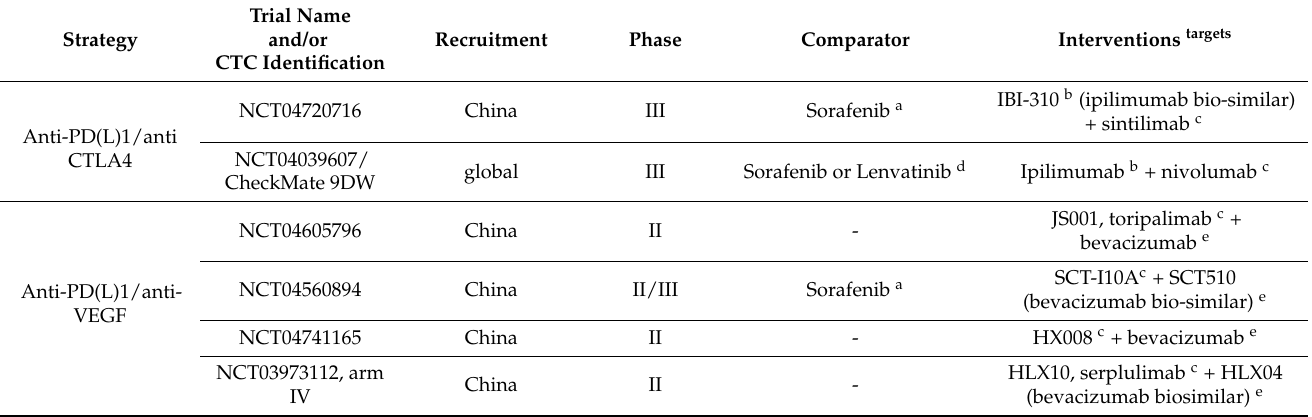
Table 2. Ongoing phase II/III trials of the following first-line combination strategies in aHCC setting, registered to Clinical Trial.gov: anti-PD(L)1/anti CTLA4; anti-PD(L)1/anti-VEGF; anti-PD(L)1/multi- target